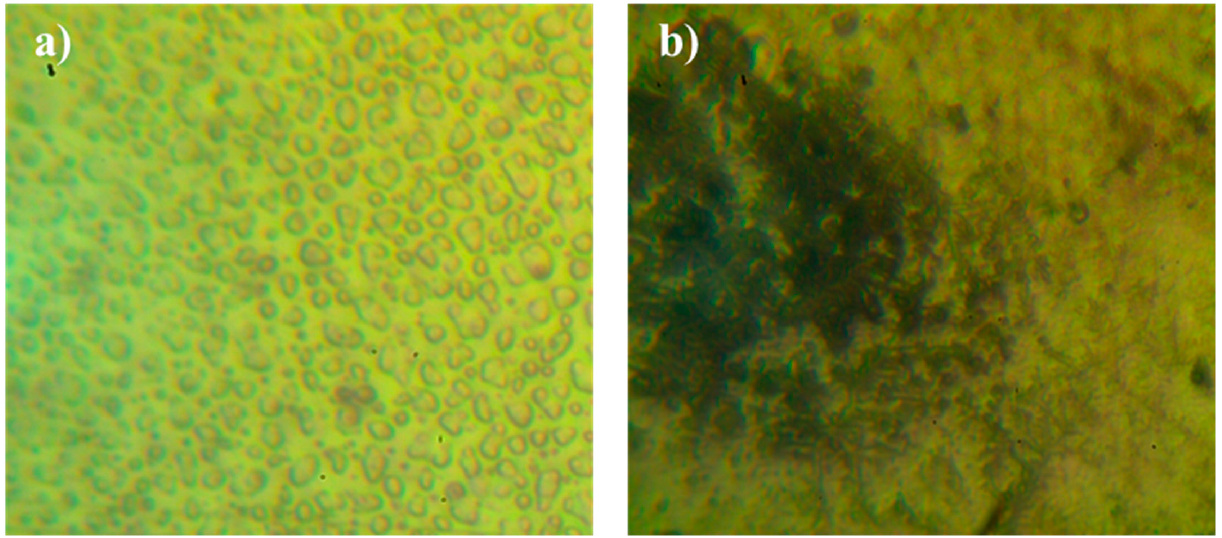
Figure 10. Microscope images of ( a ) PVC film without irradiation, ( b ) PVC film after irradiation at 300 h.